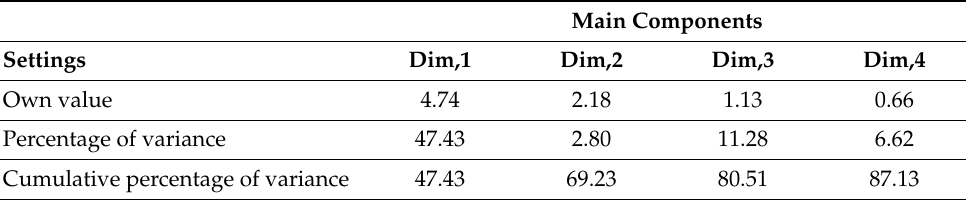
Table 5. Eigenvalues of the correlation